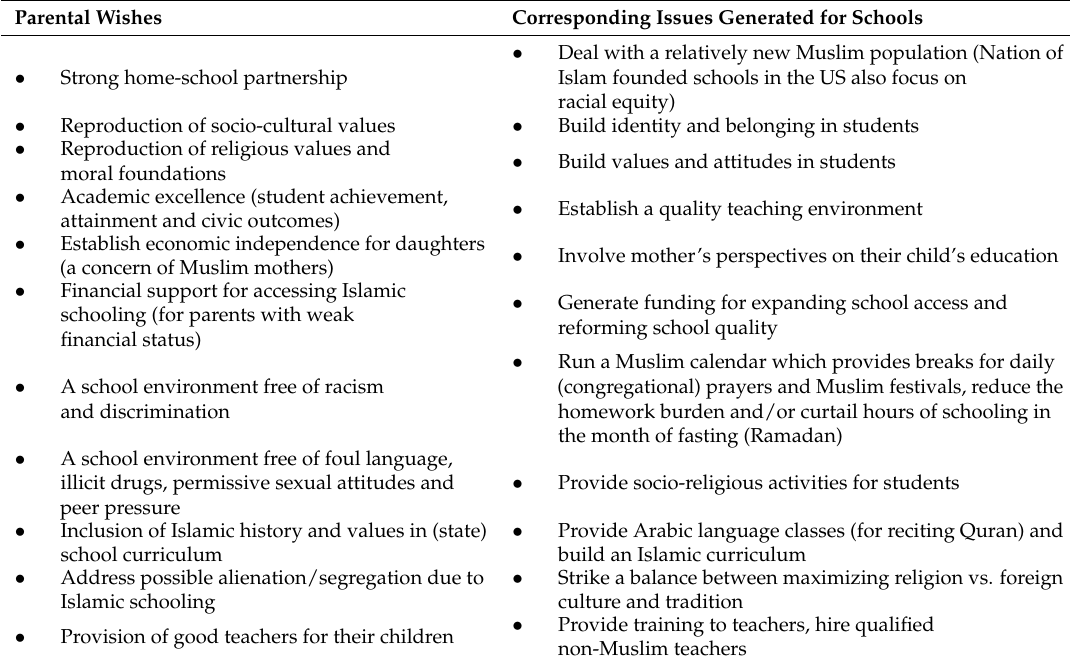
Table 4. List of parental wishes and the issues they generate for